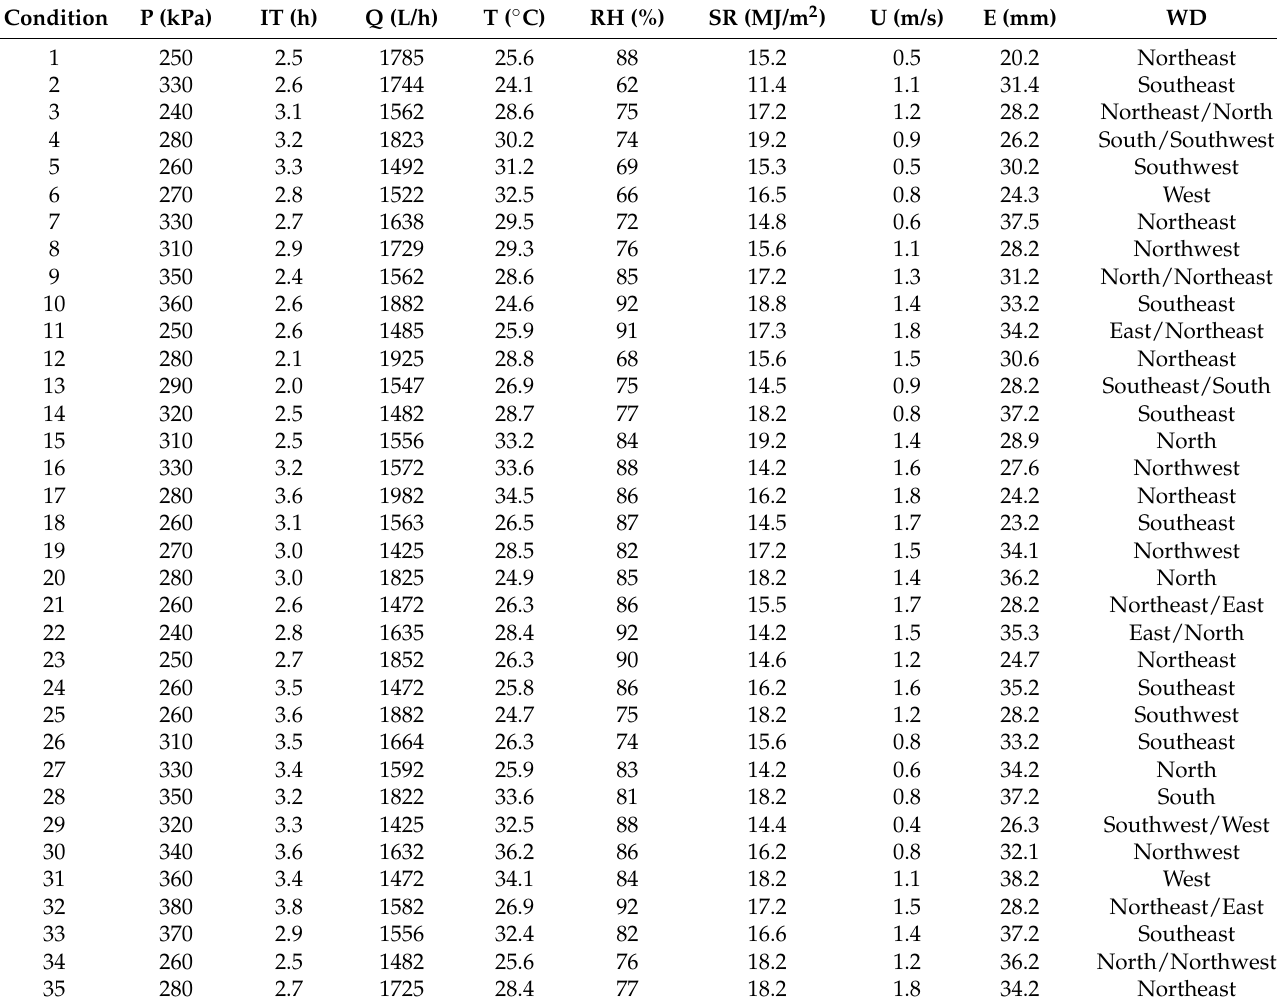
In Figure 6, for the accurate prediction of infiltration rates, clods of soil crust with a thickness of 10 cm on different soil depth layers (vertical depth ranged from 0 to − 500 cm) were sampled out and observed closely after each irrigation test was completed. The average distribution of water precipitation was measured at a rectangular area of 15 × 15 m 2 in calm conditions. Such environmental parameters as average air temperature (T, ◦ C), average air relative humidity (RH, %), and solar radiation (SR) were collected every 10 min. Here, local air temperature was measured by an HW-F7 thermometer (LD Products Inc. California, USA), air relative humidity was determined by using Testo 610 hygrometers (Testo Pty Ltd, Croydon South, Australia), and solar radiation value could be obtained from an LI-1500 irradiance radiometer (HUATEC. Beijing, China). Since wind speed (U, m/s) has a decisive influence on the evaporation loss of soil moisture, it was measured by RK100-02 RS485 wind speed measurement units (RIKA Sensor Inc., Hunan, China). On the other side, the soil moisture evaporation measurements (E, mm) were carried out by 40 sets of newly developed microlysimeter, which equally distributed throughout the whole field area. All these parametric variables were measured at row and inter-row irrigation positions, and then they were averaged across all measurement positions to provide accurate